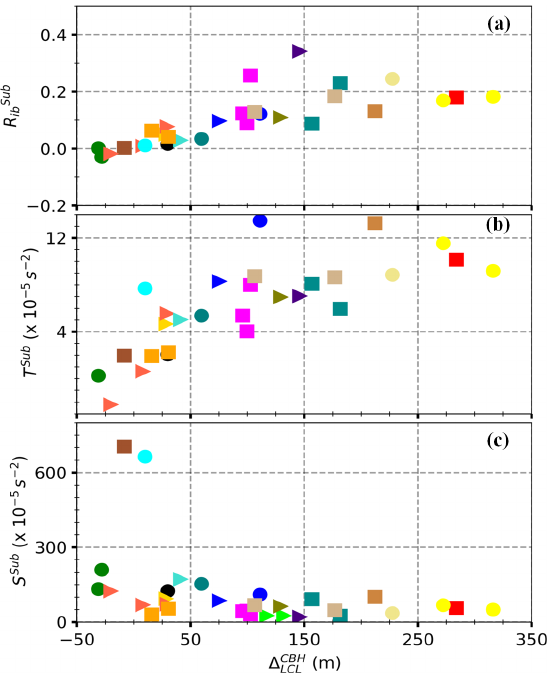
Figure 4. Bulk Richardson number ( R Sub ; a ) and its thermal ( T Sub ; ib b ) and vertical wind shear ( S Sub ; c ) composing terms as a function of the diagnostic parameter (cid:49) CBH , which corresponds to the mean LCL distance between the LLSC base height (CBH) and the surface- based lifting condensation level (LCL), performed by using all ra- diosoundings available from 04:00 to 06:30UTC on day- D + 1 for each studied case. Each marker corresponds to one